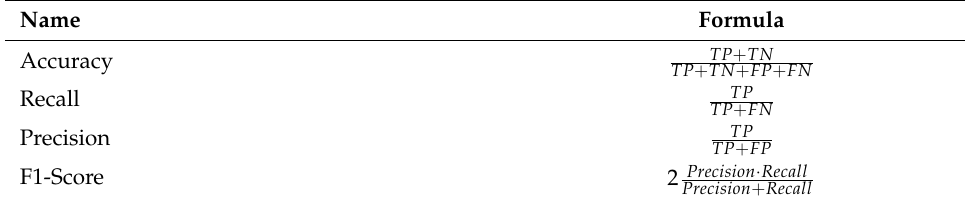
Table 3. Performance metrics.